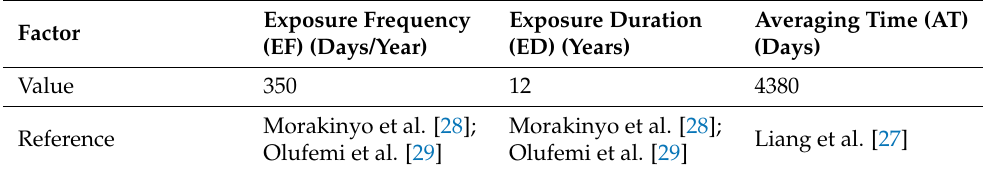
Table 1. PM 2.5 exposure factors used for uptake through the respiratory system.